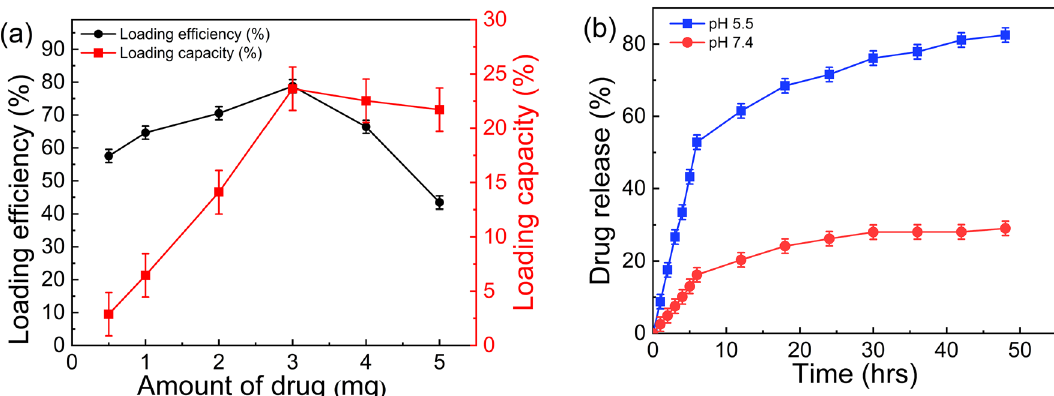
Figure 6. The loading and release of NTD ( a ) Drug loading efficiency and drug loading capacity when 1 mg MNS was reacted with different amounts of NTD, ( b ) Drug release from MNS-APTES-NTD nanoformulation at pH 7.4 and pH 5.5 in PBS (37